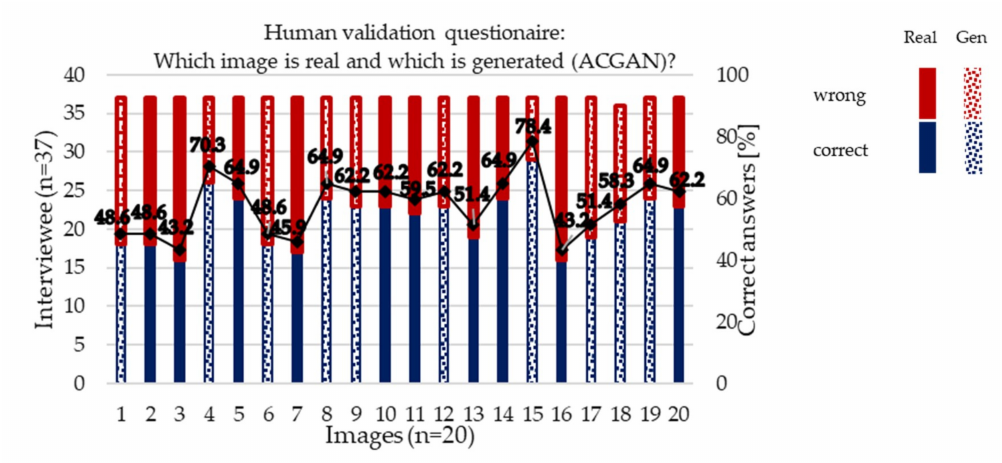
Figure 6. Interviewee (n = 37) responses to the discrimination of real and generated ACGAN images questionnaire.